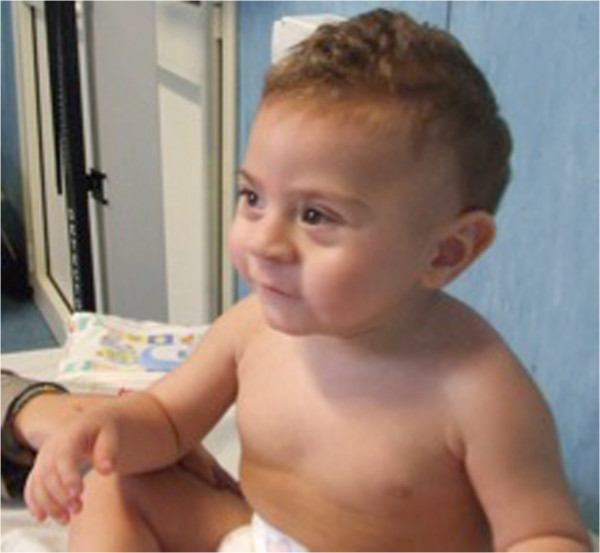
The boy at the age of 1 year. Note low set ears, epicanthus and thin upper-lip.